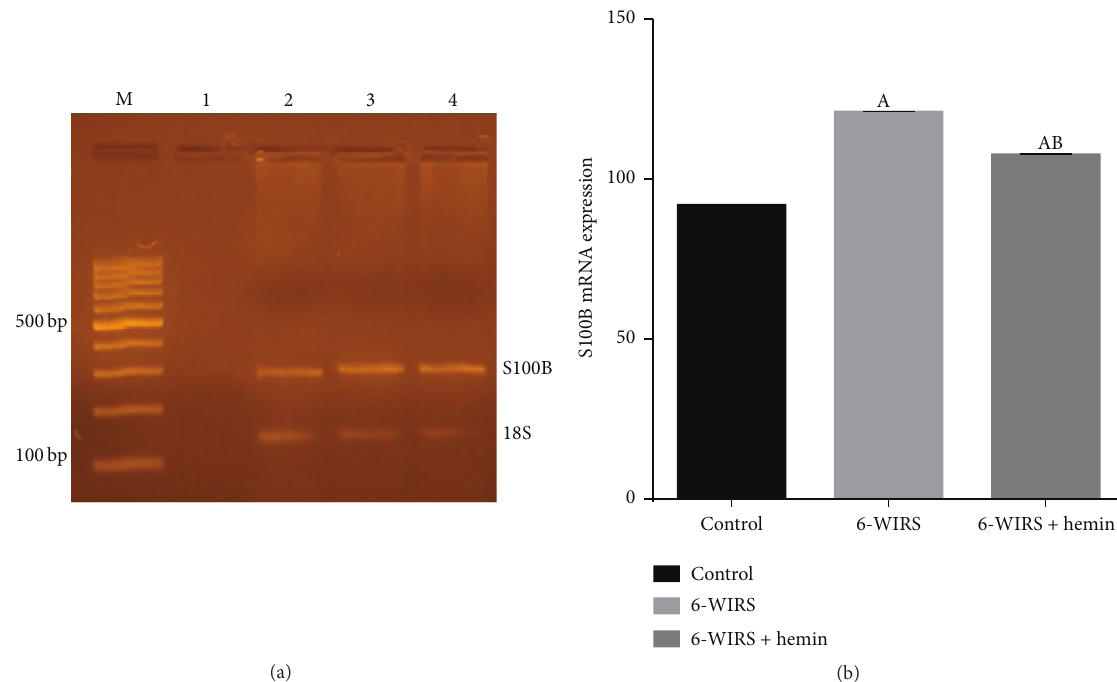
Figure 3: Effect of 6-hour water immersion restraint stress (WIRS) with and without hemin on protein S100B mRNA expression in brain. (a) M: 100bp ladder. Lane 1: negative control, lane 2: control group, lane 3: WIRS group, and lane 4: hemin-treated group. (b) A Significant difference from the control group and B significant difference from the WIRS group, 𝑝 ≤ 0.05. Values are expressed as mean ± SEM of 10 rats in each